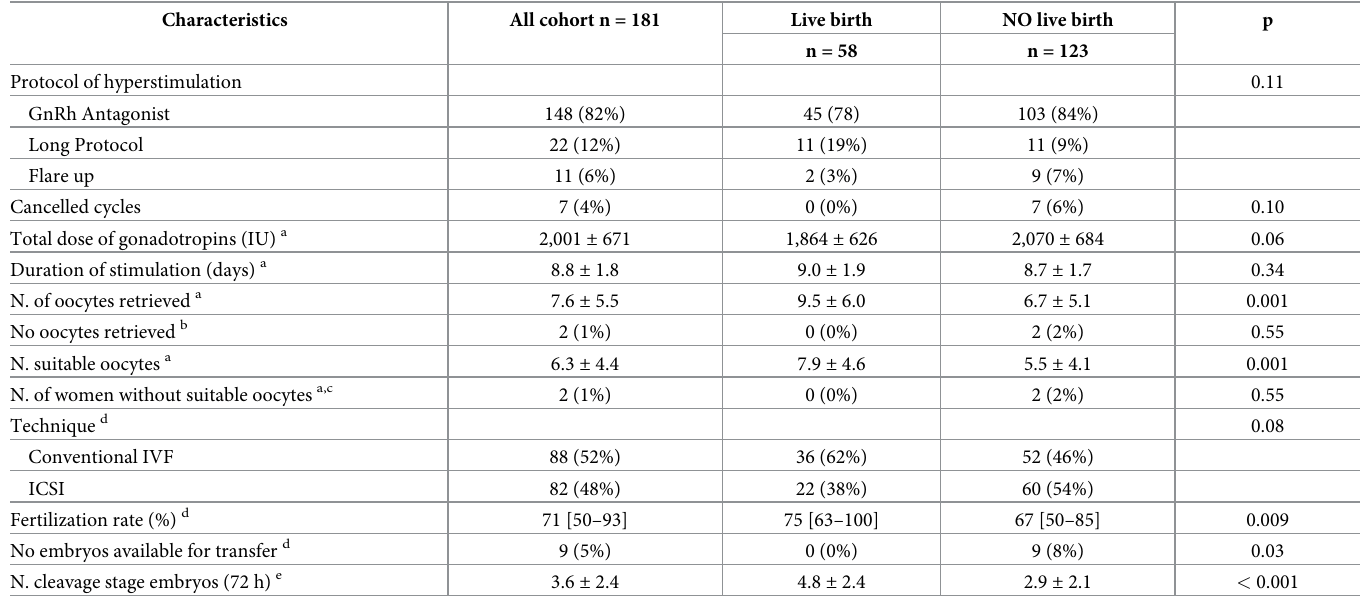
Table 2. IVF cycle outcome in the whole cohort and comparison between women who did and did not obtain a live birth. Characteristics